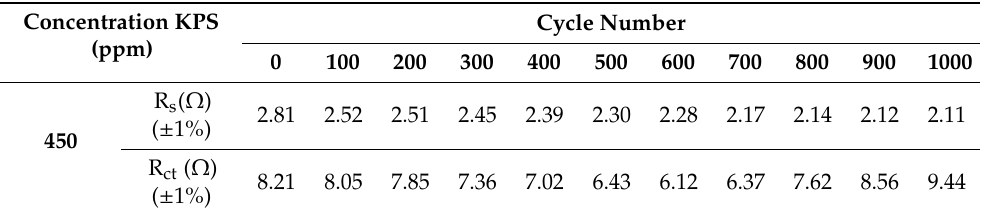
Table 3. Resistance values of cell impedance after every 100 cycles of CV for the open cell with the electrolyte containing 450 ppm